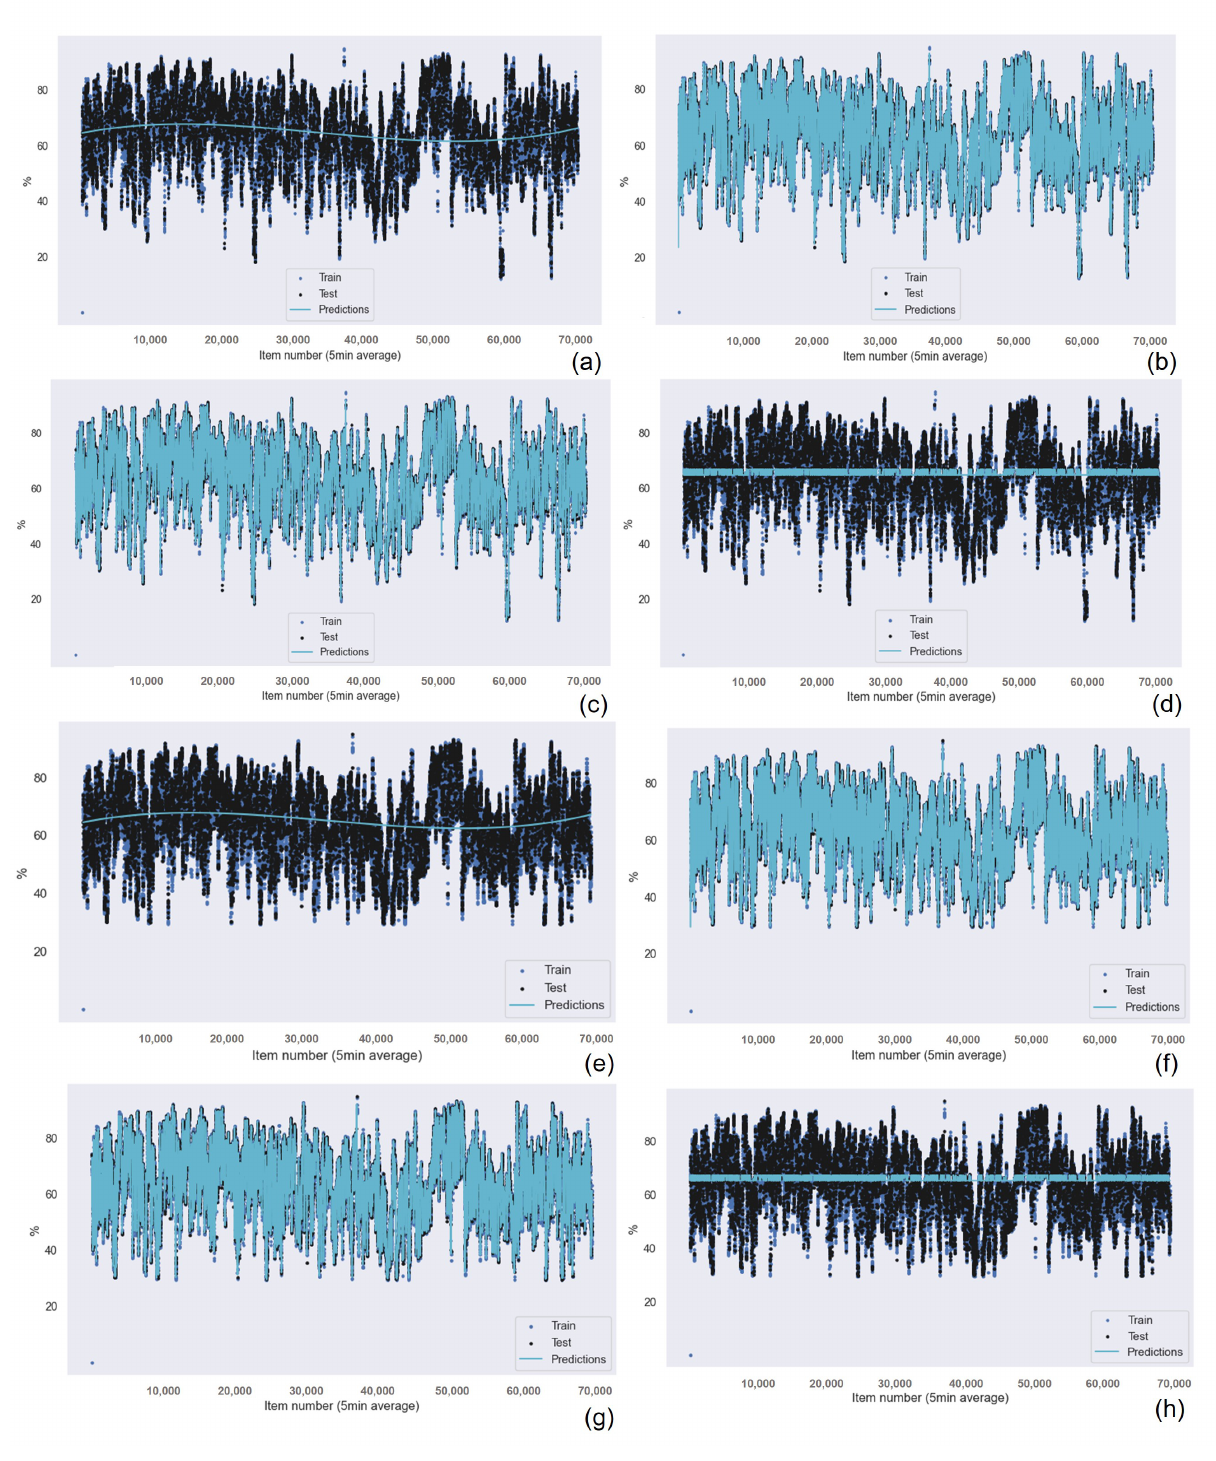
Figure A9. Humidity results with outliers for ( a ) Linear Regression ( b ) Random Forest Regression ( c ) KNN and ( d ) Support Vector Machine, and without outliers for ( e ) Linear Regression ( f ) Random Forest Regression ( g ) KNN and ( h ) Support Vector